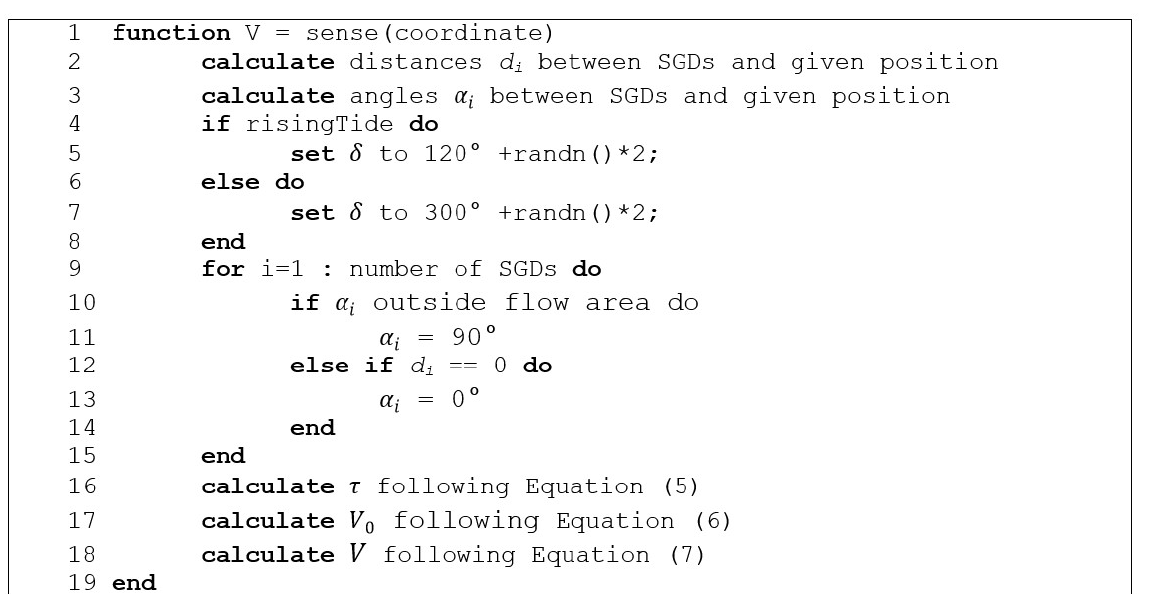
Figure 8. Pseudocode for sensing the simulated environment.